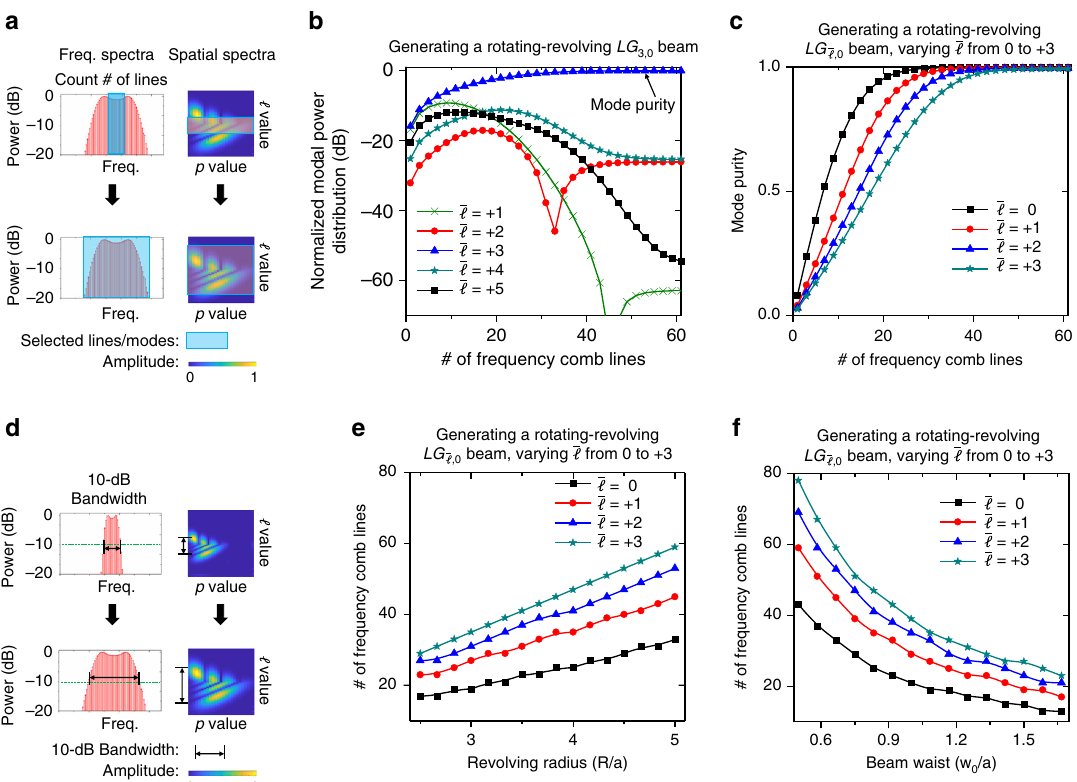
Fig. 6 The relationship between the quality of the rotating-revolving LG-- beams and the frequency spectrum. a We fi rst calculate the spatiotemporal ‘; 0 spectra of the rotating-revolving beam using the approach described in Methods, and then we select a certain number of frequency lines/modes from the calculated spectra for power/mode purity calculation in ( b ) and ( c ). b The power distribution on light beams with different rotating (cid:1) ‘ values for generating a rotating-revolving LG 3,0 beam, when the number of selected frequency comb lines is varied. c The mode purity of a generated rotating-revolving LG (cid:1) ‘; 0 beam ( (cid:1) ‘ varies from 0 to + 3), when the number of selected frequency comb lines is varied. d We calculate the spatiotemporal spectra of different rotating- revolving beams and count the number of frequency lines in the 10-dB bandwidth of the frequency spectra; panels ( e ) and ( f ) show the number of frequency comb lines in the 10-dB bandwidth for generating a rotating-revolving LG (cid:1) ‘; 0 beam with (i) the same beam waist of w 0 = 0.2 mm and a revolving radius of R varied from 0.75 to 1.5 mm; and (ii) the same revolving radius of R = 1.5 mm and a beam waist of w 0 varied from 0.15 to 0.5 mm, respectively. a = 0.3 mm in ( e ) and ( f